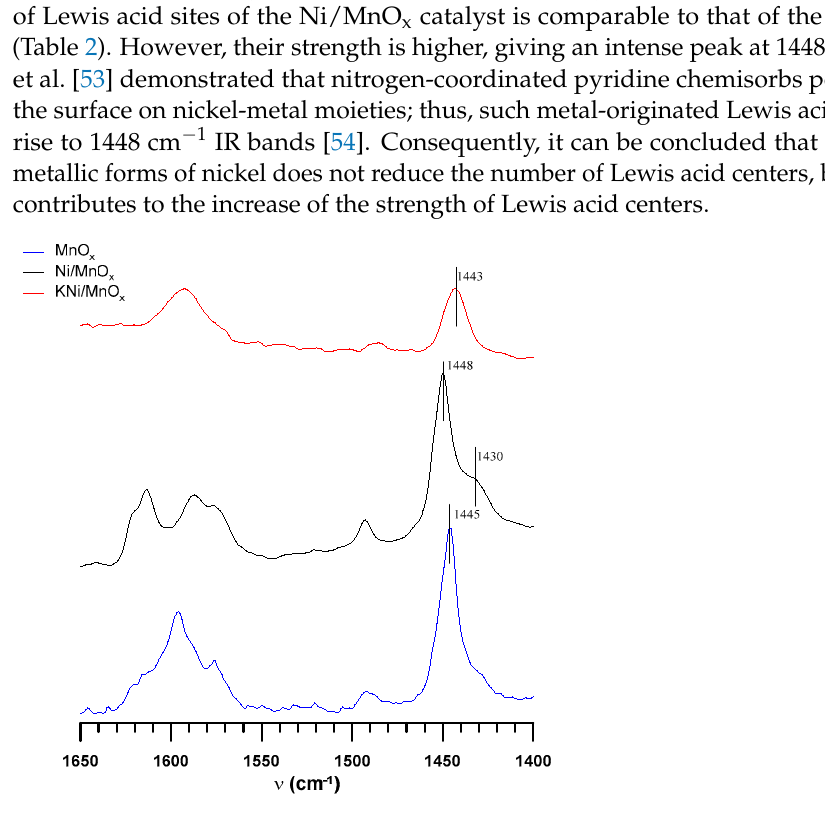
Figure 4. FT-IR spectra of pyridyne interacting with the Lewis acid sites of MnO x support and Ni/MnO x and KNi/MnO x catalysts. Table 2. The comparison of the content of Lewis acid sites for MnO x support and Ni/MnO x and KNi/MnO x